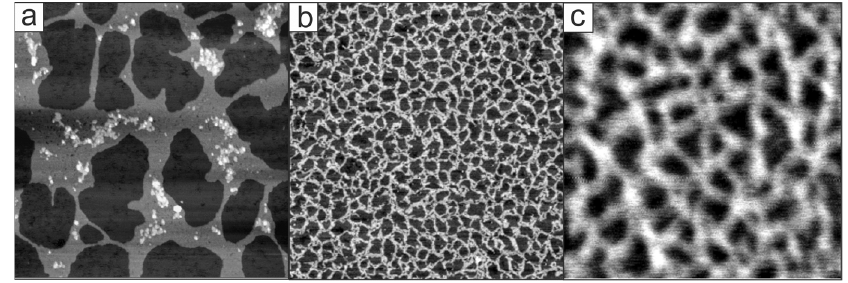
Figure 5. AFM images of ( a ) P5 , ( b ) and ( c ) P4 layers deposited on mica from solutions in chloroform. Scanning area: ( a , b ) 2.5 × 2.5 µm 2 , ( c ) 1 × 1 µm 2 .